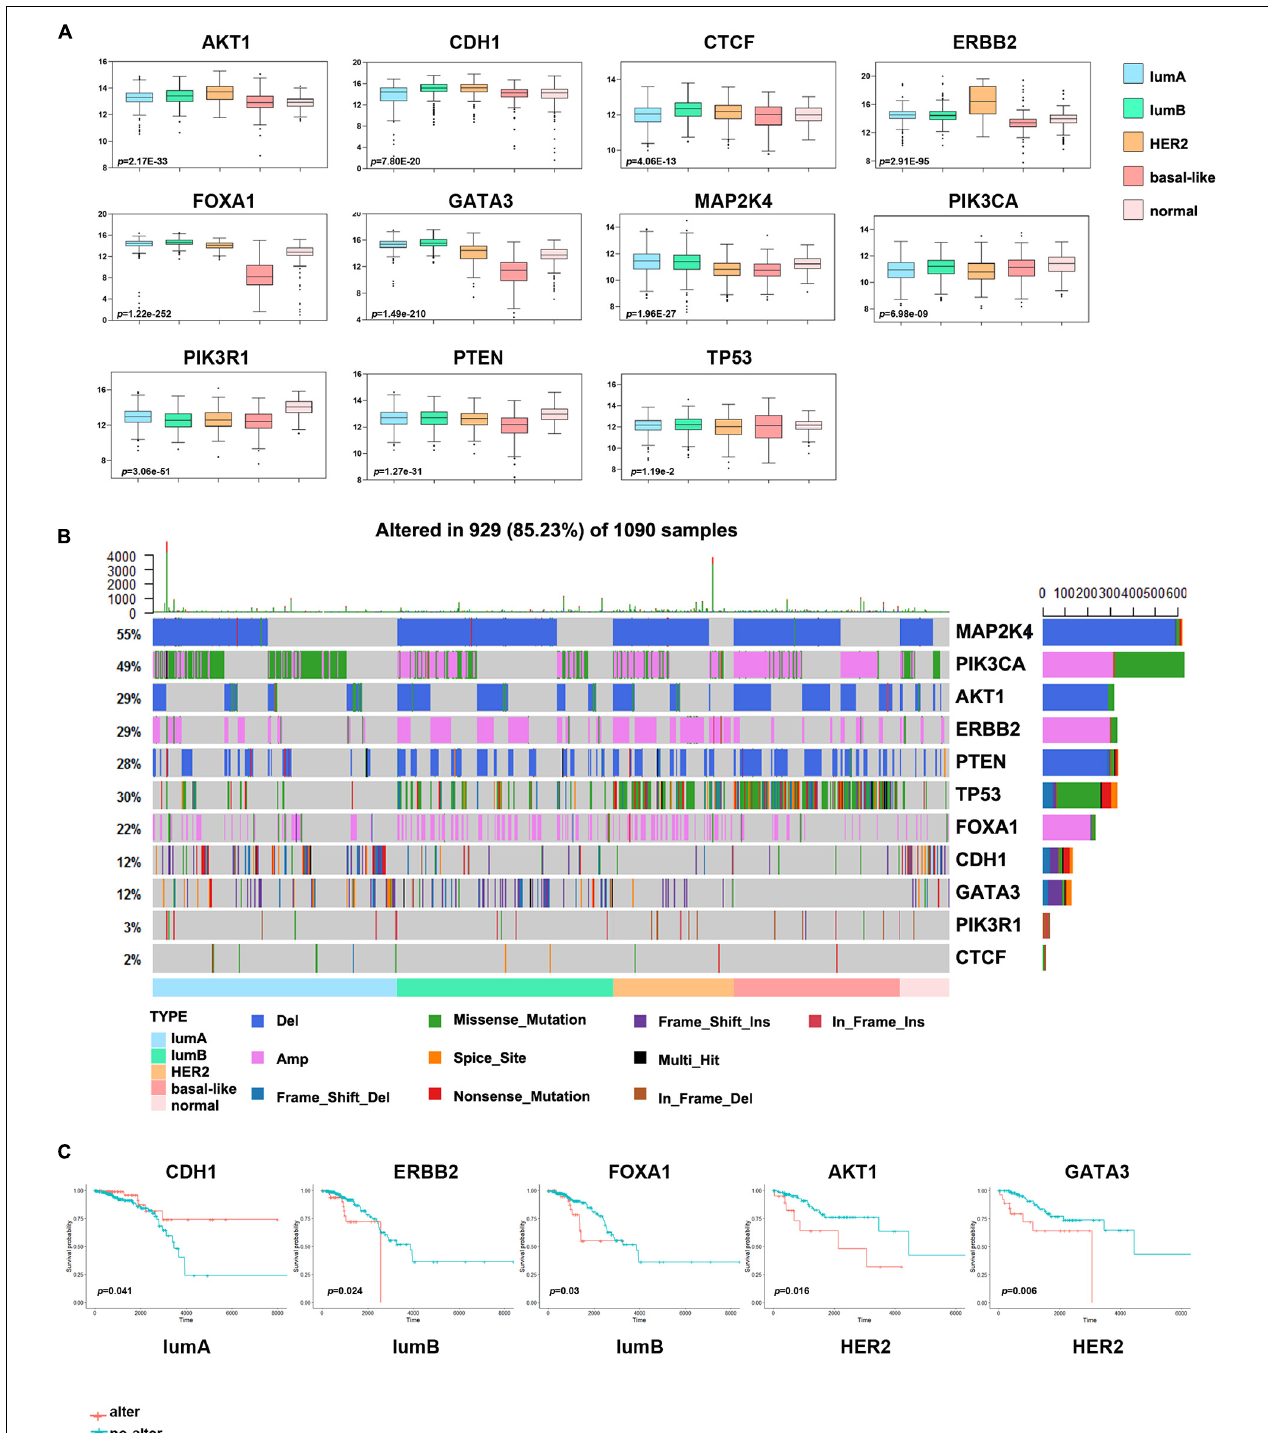
FIGURE 4 | Analysis of the driver genes in different breast cancer subtypes. (A) The expression levels of eleven driver genes in each subtype. (B) The waterfall chart shows the frequency mutations of the driver genes in each subtype. (C) Kaplan–Meier survival curve of the driver genes with gene mutations. Red indicates the gene alteration group, and blue indicates the non-alteration